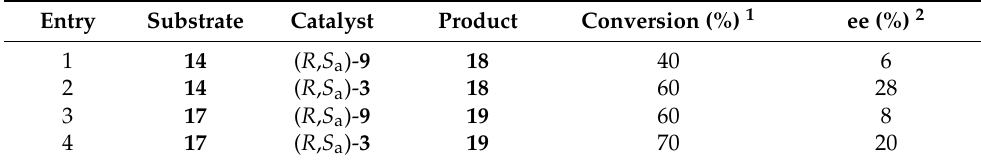
Table 1. Asymmetric cyclization of 2 ‐ hydroxychalcones 14 and 17 .